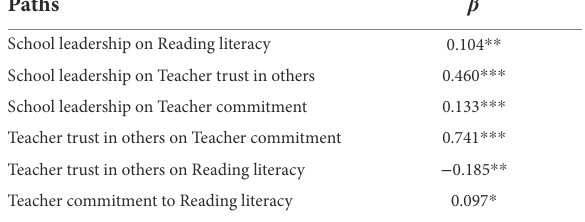
TABLE 2 Path analysis results. Paths